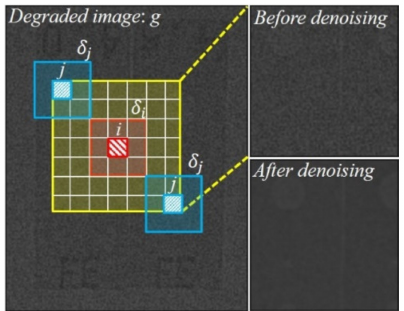
Figure 1. Schematic illustration of non-local means method for e ff ective noise reduction in high-energy X-ray images.